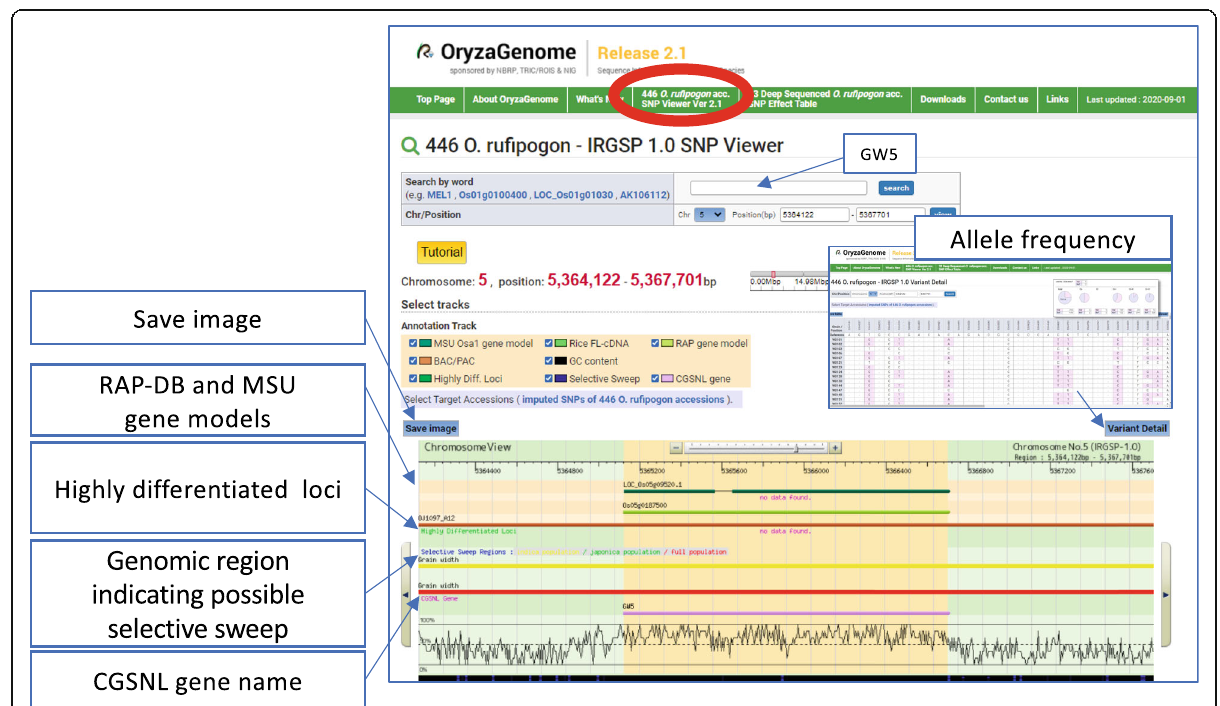
Fig. 2 Genome-browser-oriented SNP Viewer for the 446 imputed O. rufipogon variants showing the Os05g0187500 gene region. A new function, based on previous data (Huang et al. 2012), graphically represents genomic regions in O. sativa where selective sweeps may have occurred: red bars, whole population; yellow bars, only in indica populations; green bars, only in japonica populations. This release also graphically shows regions with higher mutation rates (i.e., highly differentiated loci). Allele frequencies in a region can be displayed by clicking on the “ Variant Detail ”